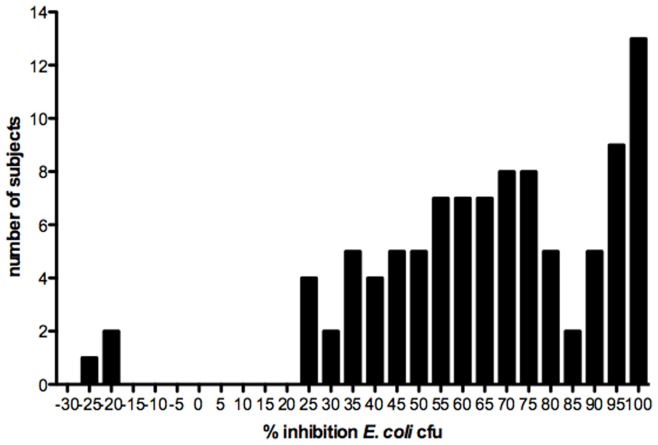
Distribution of CVL E. coli bactericidal activity from a cohort of 99 healthy females.Each CVL or control fluid (200 µg/mL of bovine serum albumin in normal saline) was mixed with ∼109 cfu of E. coli for 2 h. The mixture was then diluted to yield 800–1000 cfu on control plates and plated in duplicate on tryptic soy agar plates. Colonies were counted after 24 h incubation and the mean percentage inhibition relative to the control plates was determined.